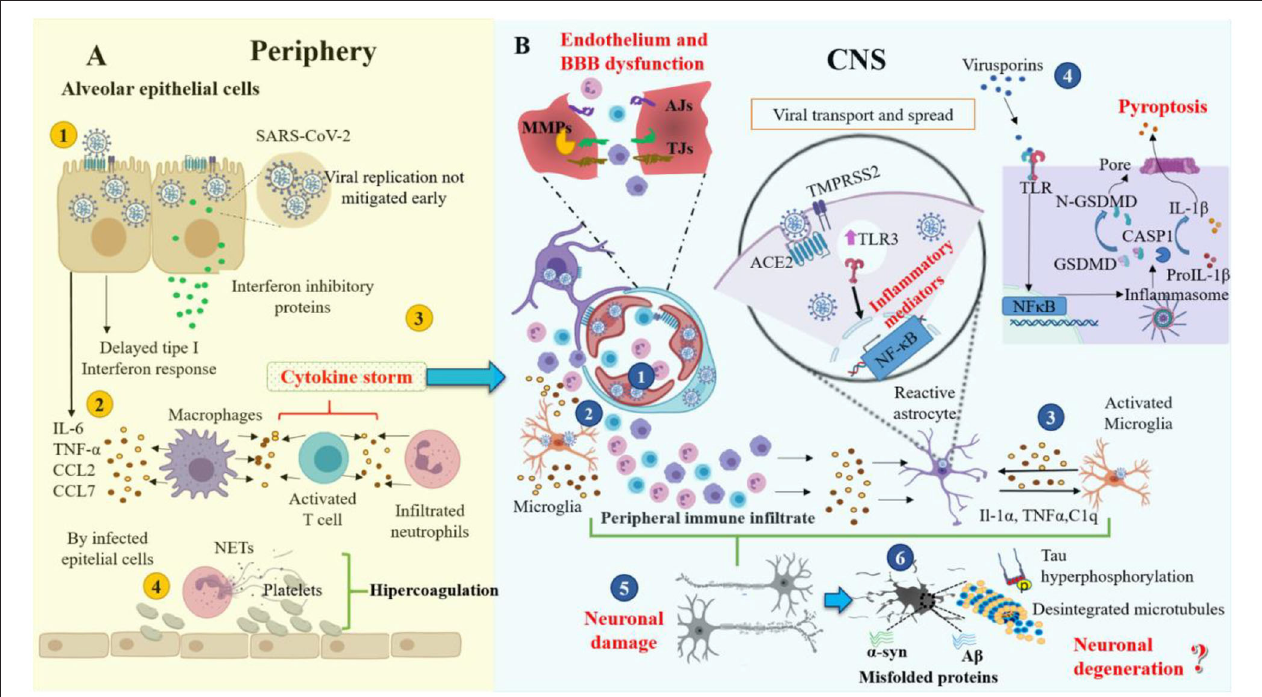
FIGURE 2 | Schematic representation of the pathophysiological mechanisms of SARS-CoV-2. (A) Peripheral pathological events triggered by SARS-CoV-2 infection. (B) Possible CNS pathological mechanisms caused by the severe peripheral hyperinflammation associated with COVID-19. ACE2, angiotensin-converting enzyme 2 receptor; AJs, adherent junctions; A β ; amyloid-beta; BBB, blood-brain barrier; C1q, the complement component 1q; CASP1, caspase1; CCL, chemokine (C-C motif) ligand; CNS, central nervous system; CXCL10, C–X–C motif chemokine 10; GSDMD, gasdermin-D; IL, interleukin; MMPs, metalloproteinases; NETs, neutrophil extracellular traps; NF- κ B, Nuclear factor Kappa B; N-GSDMD, N-terminal gasdermin; NLRP3, nucleotide-binding domain-, leucine-rich repeat-containing receptor, pyrin domain-containing 3; TJs, tight junctions; TLR3, toll-like receptor 3; TNF- α , tumor necrosis factor-alpha; α -syn, alpha-synuclein.